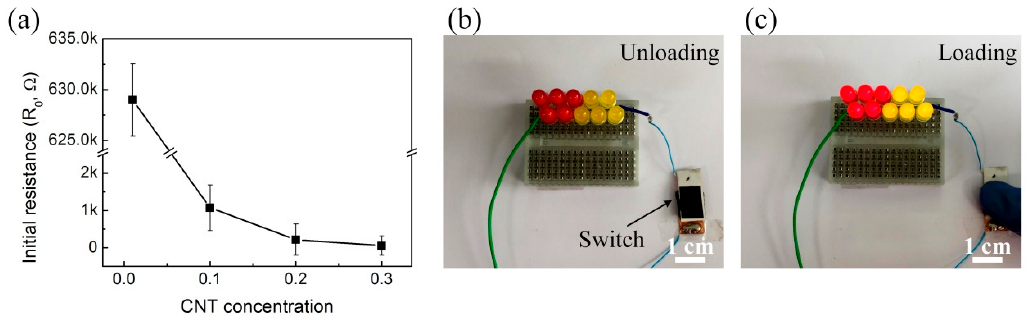
Figure 7. Electrical properties of the CPCS. ( a ) Change in initial resistance of CPCS according to the CNT concentration (from 0.01 to 0.3). ( b ) The CPCS used as a resistor switch. LED bulbs turned off when the CPCS switch was unloaded. ( c ) LED bulbs turned on as soon as the CPCS switch was pressed.